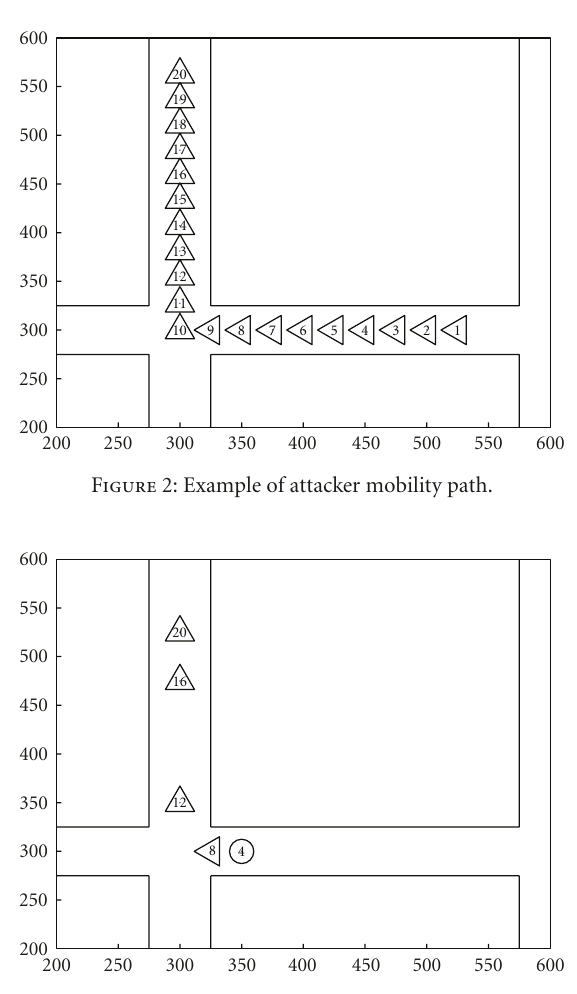
Figure 3: Example of mobile attacker localization.